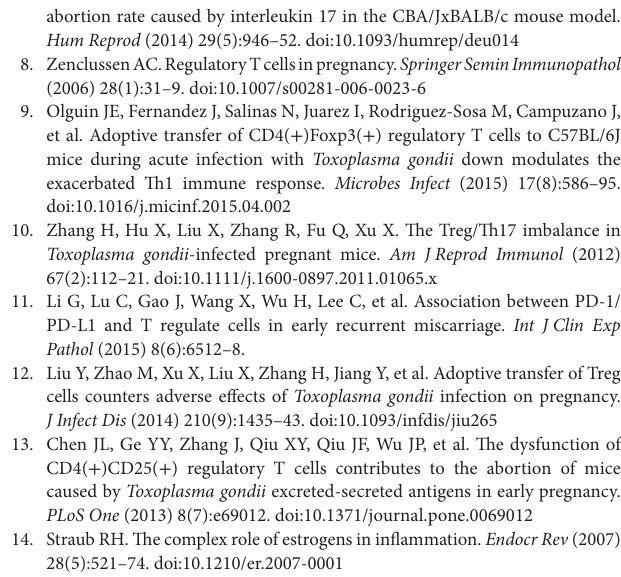
FigUre 8 | Estradiol (E2) in vivo administration in nonpregnant mice increased the expression of programmed death-1 (PD-1). (a) Overlay of representative histograms showing PD-1 expression on CD4 + T cells from spleens and inguinal lymph nodes of mice with E2 in vivo administration. The related dot plots were shown in Figure S6A in Supplementary Material. The percentage of PD-1 + cells in CD4 + T cells (B) and the mean fluorescence intensity (MFI) of PD-1 expression on CD4 + T cells (c) from spleens and inguinal lymph nodes of mice with E2 in vivo administration. Data are represented as the means ± SD of six mice for each group from one experiment representative of two independent experiments. Significance was determined by one-way ANOVA. *** P < 0.001, ** P < 0.01, * P < 0.05. (D) Overlay of representative histograms showing PD-1 expression on CD4 + CD25 + Foxp3 + T cells from spleens and inguinal lymph nodes of mice with E2 in vivo administration. The related dot plots were shown in Figure S6B in Supplementary Material. The percentage of PD-1 + cells in CD4 + CD25 + Foxp3 + T cells (e) and the MFI of PD-1 expression on CD4 + CD25 + Foxp3 + T cells (F) from spleens and inguinal lymph nodes of mice as mentioned above. Data are represented as the means ± SD of six mice for each group from one experiment representative of two independent experiments. Significance was determined by one-way ANOVA. *** P < 0.001, ** P < 0.01, * P <